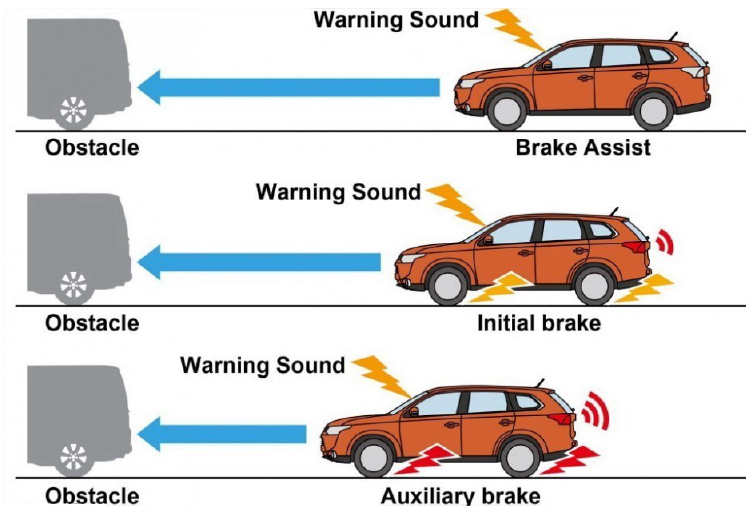
Figure 1. Basic CMBS system